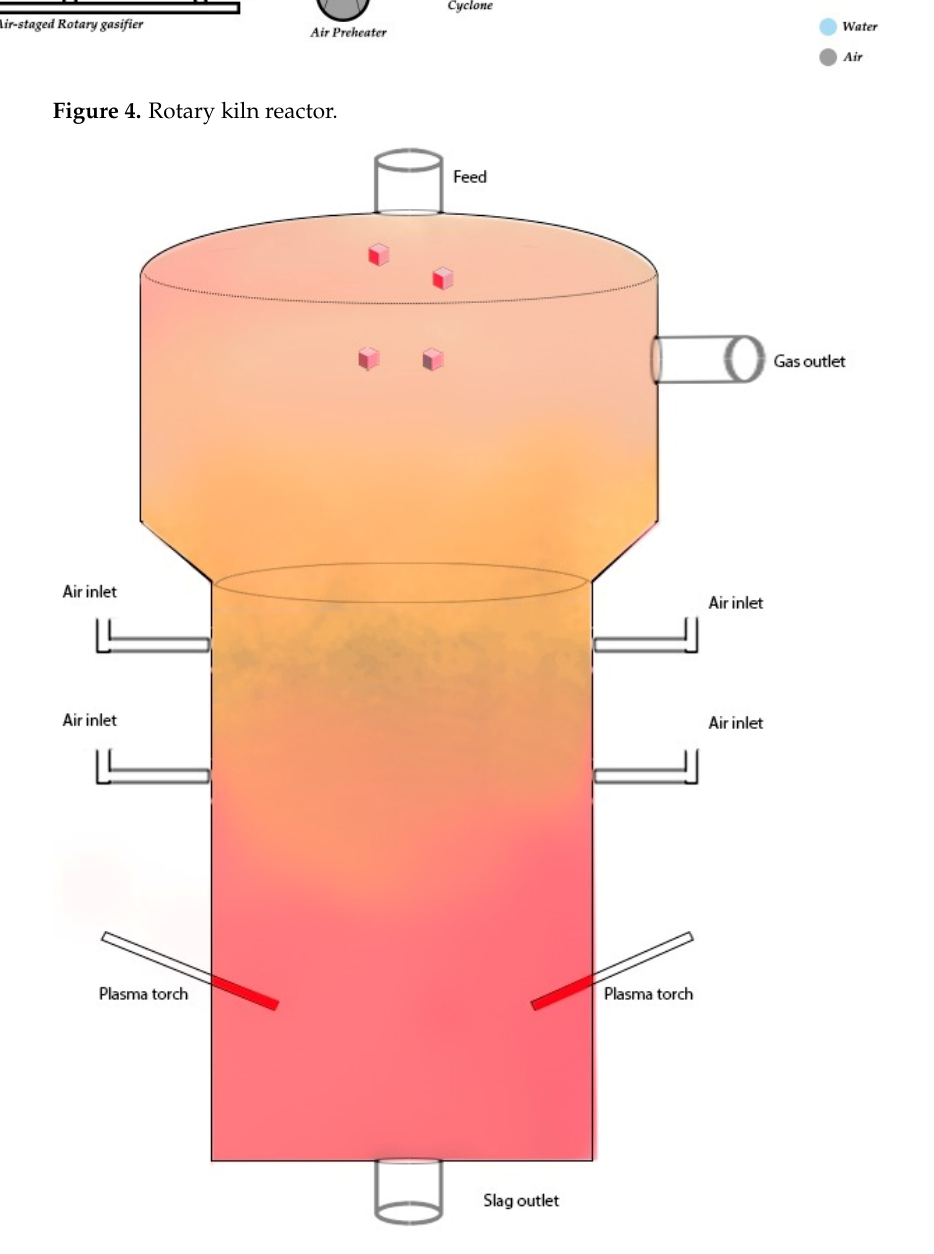
Figure 5. Plasma gasifier.